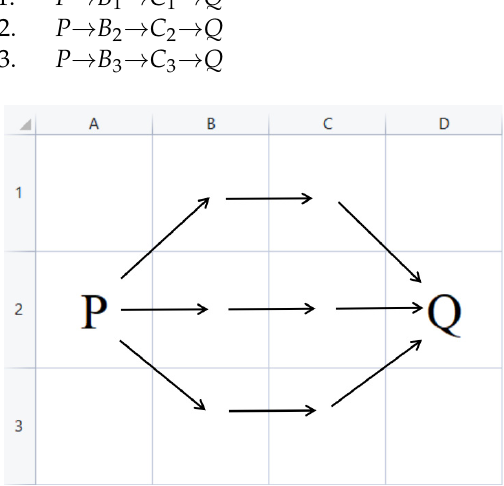
Figure 4. Path selection during search.